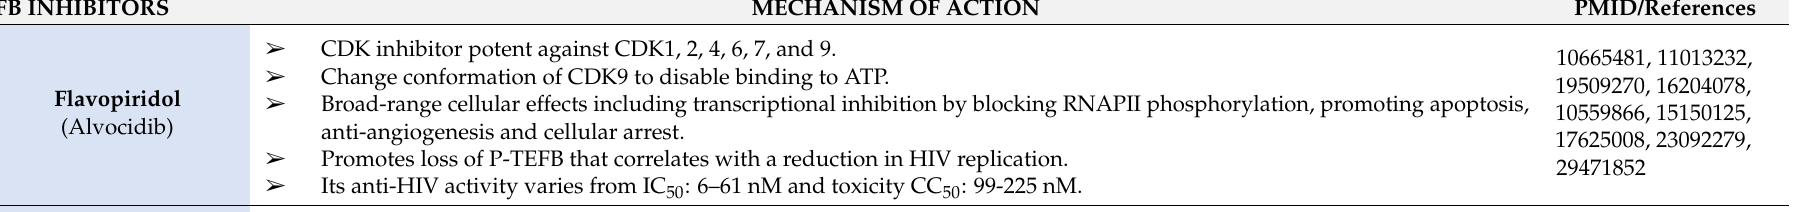
Table 1. P-TEFB inhibitors (part 1), P-TEFB inhibitors (part 2). P-TEFB